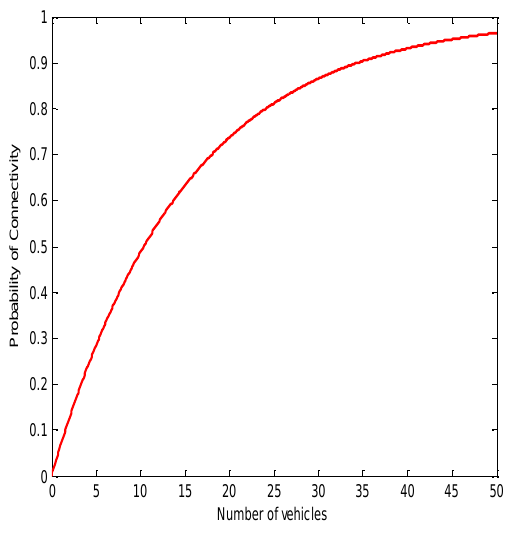
Figure 3. RSMA based 5G V2X